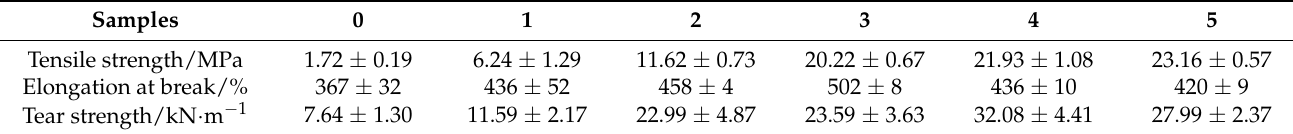
Table 3. Mechanical properties of unfilled and filled SBR vulcanizates.